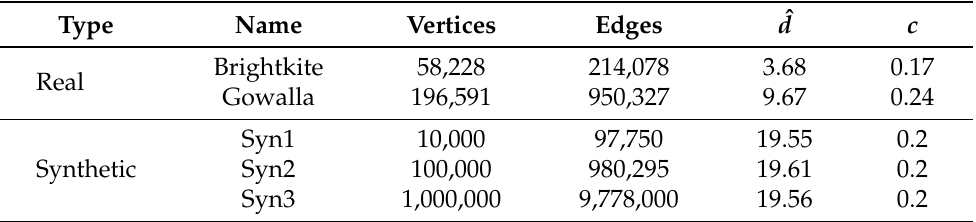
Table 2. Datasets used in our experiments (the last two columns are the average degree and the average clustering coefficient).